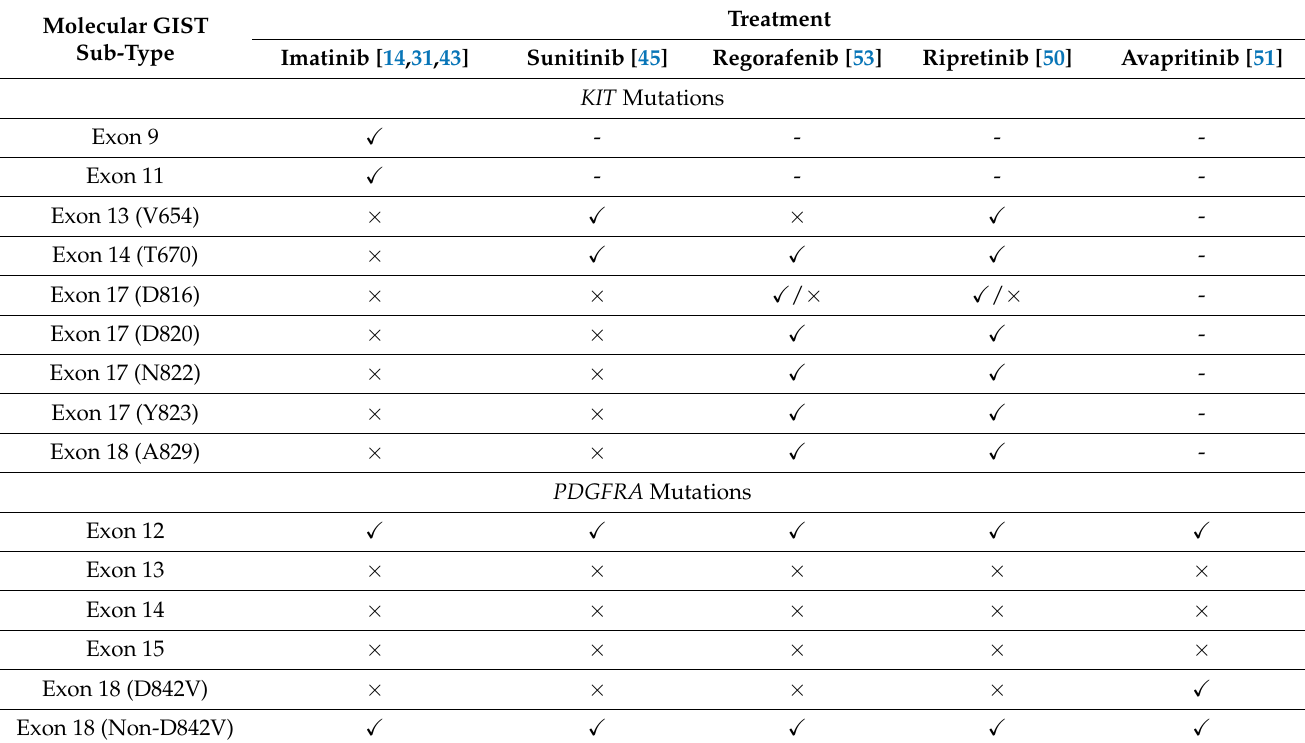
Table 1. Sensitivity profile of different molecular subtypes of KIT or PDGFRA